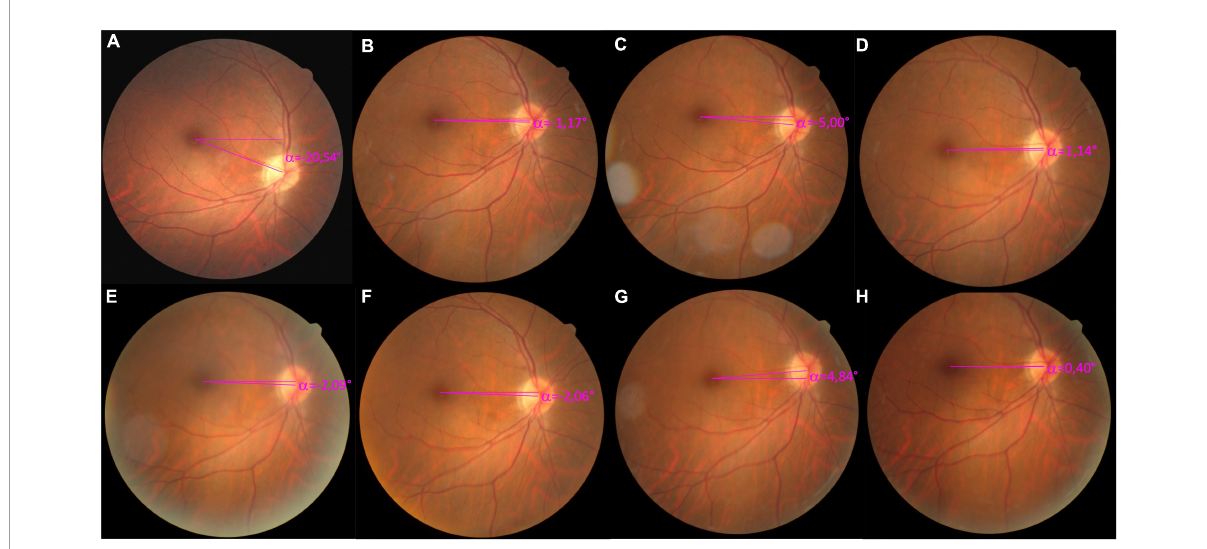
FIGURE4 Serial objective cyclotorsion changes of the right eye for Patient 1 depicted by color fundus photography. (A) Photograph acquired before the first attempted surgery with the proposed marking system, with 27 ◦ of incyclotorsion measured with the double Maddox rod (DMR) test and a − 20.54 ◦ of disc-fovea angle (DFA). (B) The 1-month postoperative results of the first surgery showed a marked improvement with the DMR test showing 3 ◦ of incyclotorsion and a markedly reduced DFA ( − 1.17 ◦ ). (C) Five months after the first reoperation, a residual subjective incyclotorsion of 10 ◦ with a − 5 ◦ DFA was noted. A second surgical procedure was then performed. (D) One month after the second surgery. (E) Two months after the second surgery. (F) Three months after the second surgery, a residual of 10 ◦ incyclotorsion measured with the DMR test was noted. A third procedure of scar revision and transposition of scar and residual muscle was performed to correct the torsion. (G) One month after the fifth reoperation. (H) Five months after the fifth reoperation. The DMR test revealed a 4 ◦ of incyclotorsion and the DFA was 0.40 ◦